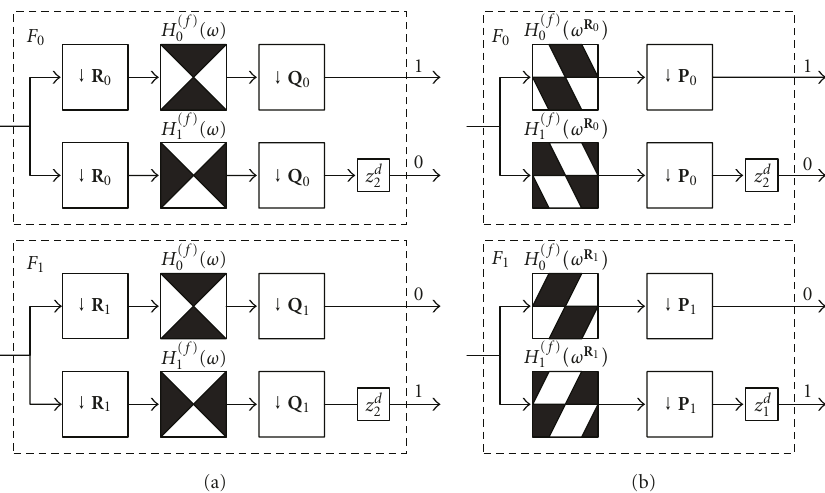
Figure 3: Resampled fan FBs of types F 0 and F 1 used after level two of the binary DFB tree: (a) original structures and (b) equivalent structures obtained by switching the resampling blocks and the filters H ( f )